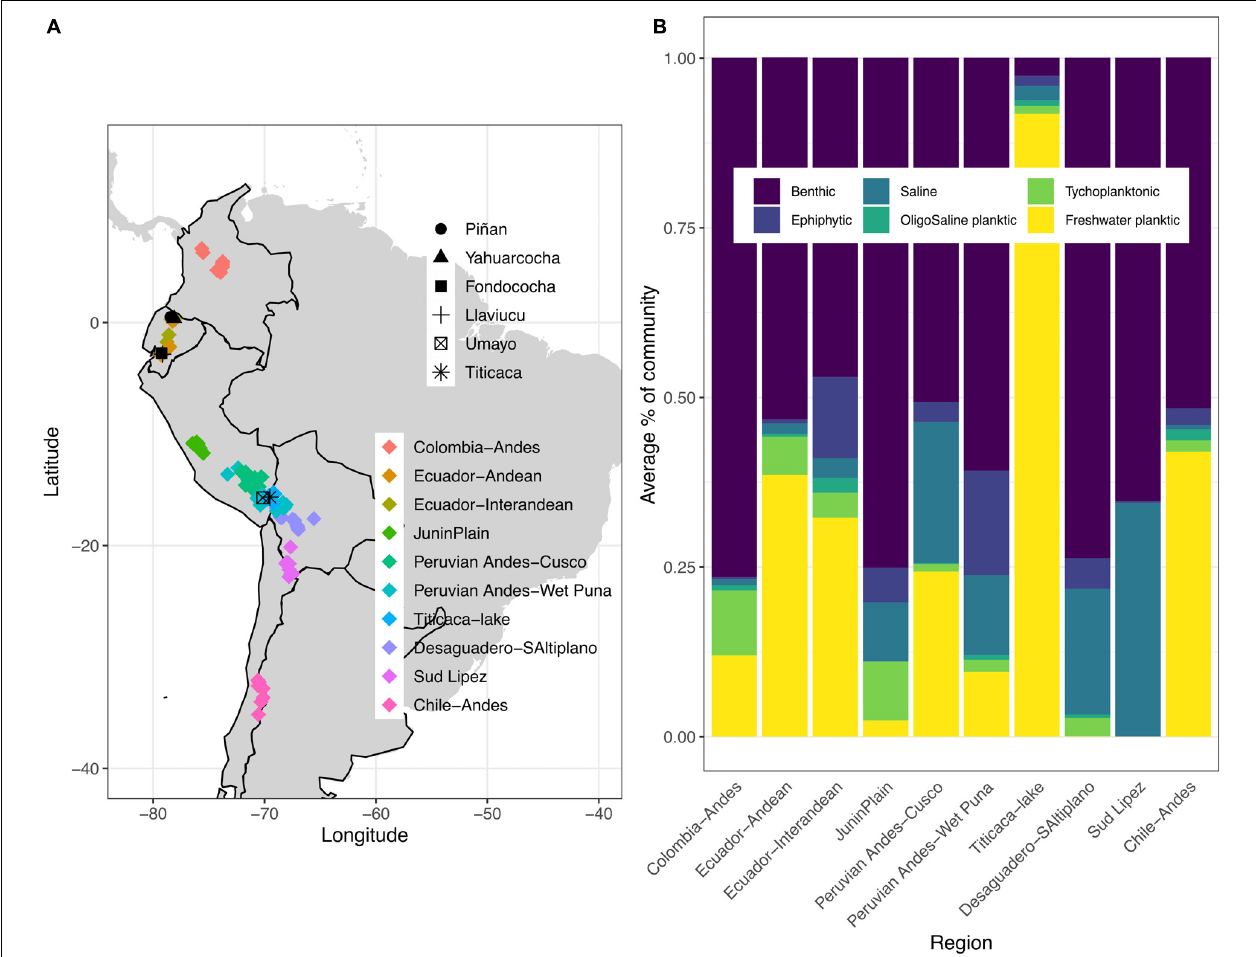
FIGURE 1 | (A) Geographical location of the modern investigated lakes ( n = 144) colored by regions within the tropical Andes of South America (see Supplementary Table 1 for individual lakes information in each region); the location of the six lake cores are also shown with different symbols; (B) Proportion of diatom ecological groups for each lake region. Samples represent sediment surface